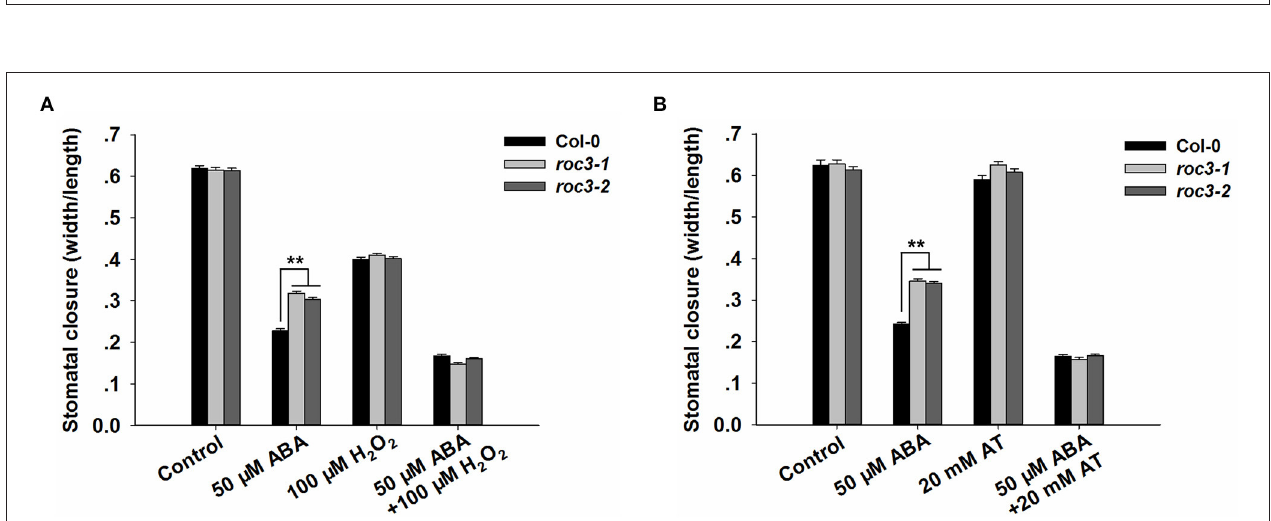
FIGURE 6 | ROC3 participates in ROS signal-regulated stomatal closure. (A) Stomatal closure assays of WT and roc3 mutant leaf epidermis treated with either ABA and/or H 2 O 2 , and stomatal aperture width/length ratios measured in at least 60 stomata per genotype per replicate. Means shown in the form mean ± SE ( n = 60), **: means differed significantly from WT ( P < 0.01). (B) Stomatal closure assays of WT and roc3 mutant leaf epidermis treated with ABA and/or AT, and stomatal aperture width/length ratios measured in at least 60 stomata per genotype per replicate. Values shown in the form mean ± SE ( n = 60), **: means differed significantly from WT (P < 0.01). Both of the experiments were repeated three times.